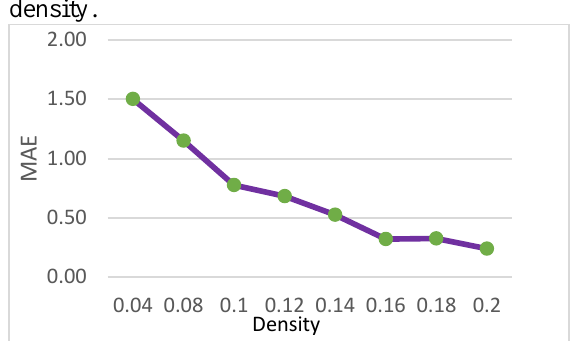
Figure 3. Impact of density.